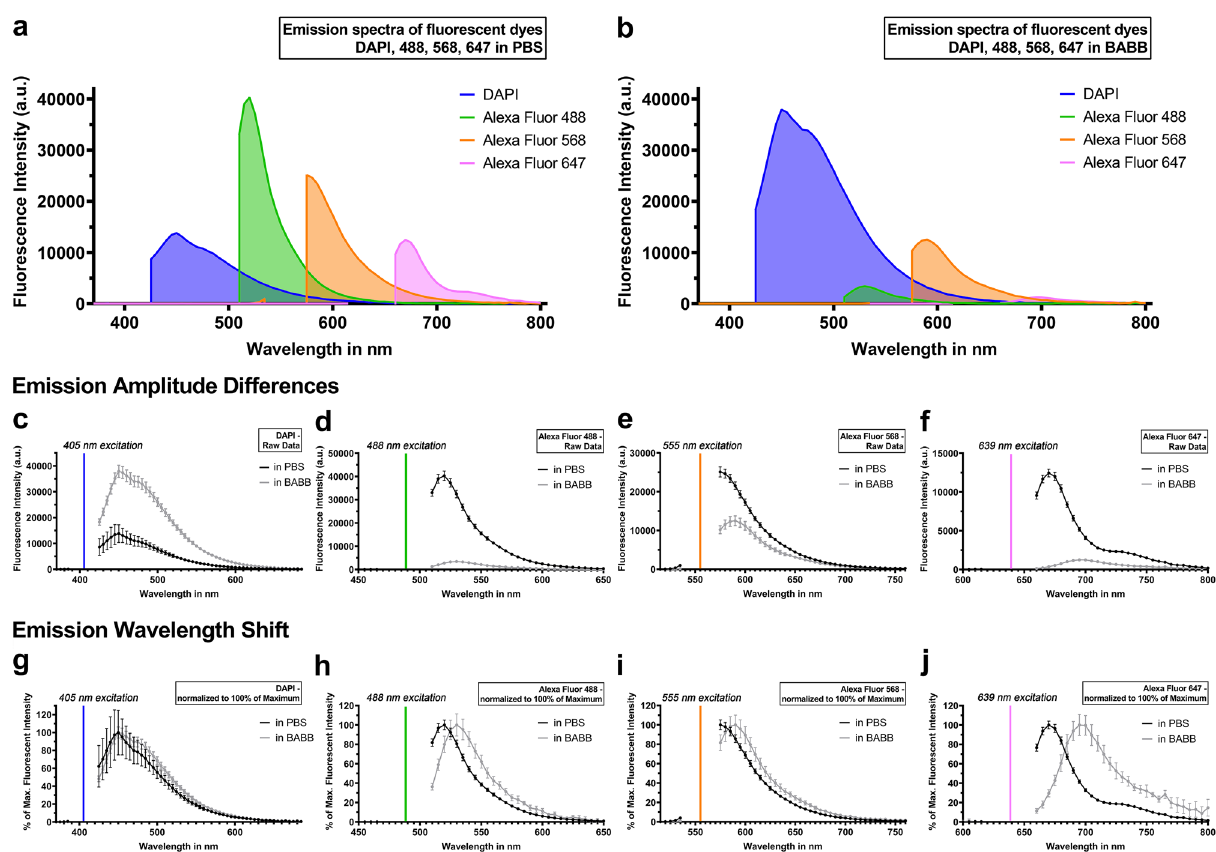
Figure 1. BABB alters the fluorescent emission spectra of fluorophores and fluorescent dyes. Plate reader-based emission spectra of Alexa Fluorophores and DAPI in PBS ( a ) vary from those in BABB ( b ). The line graphs ( c – j ) represent the individual emission signals shown in ( a , b ): Raw emission data visualize the differences in the amplitude between measurements in PBS (black line) and BABB (grey line, c – f ). Emission data normalized to their peak intensity highlight the shift of the emission peaks to longer wavelengths ( g – j ). DAPI was excited at 405 nm ( c ), Alexa Fluor 488 at 488 nm ( d ), Alexa Fluor 568 at 555 nm ( e ), and Alexa Fluor 647 at 639 nm ( f ) . In order to visually distinguish individual spectra, the gaps resulting from missing data points (see “Methods” section) were closed by vertical lines. Error bars indicate standard deviation. n = 8 independent wells for each